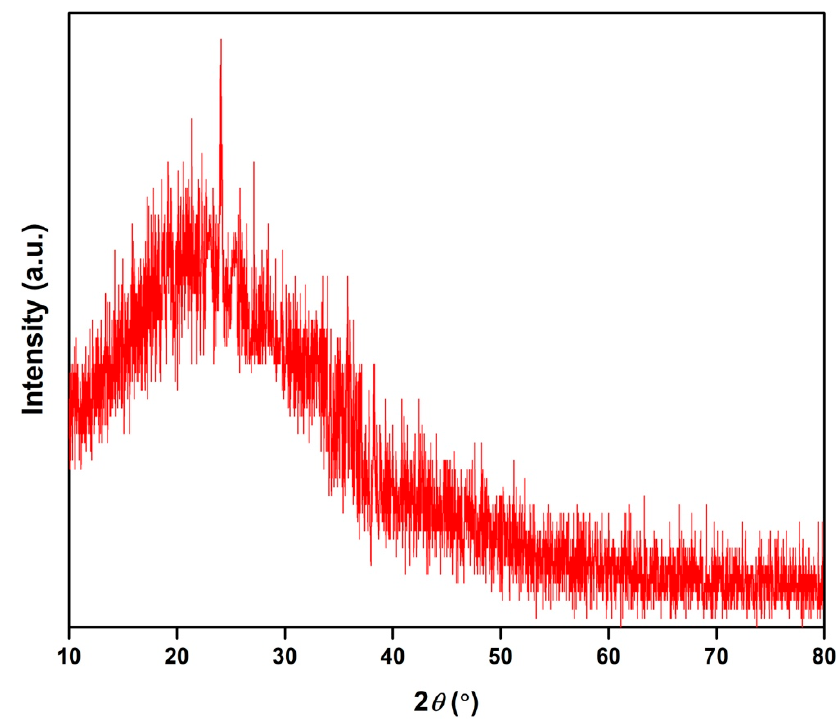
Figure 4. X-ray diffraction (XRD) pattern of BCDs nano-biocarrier.